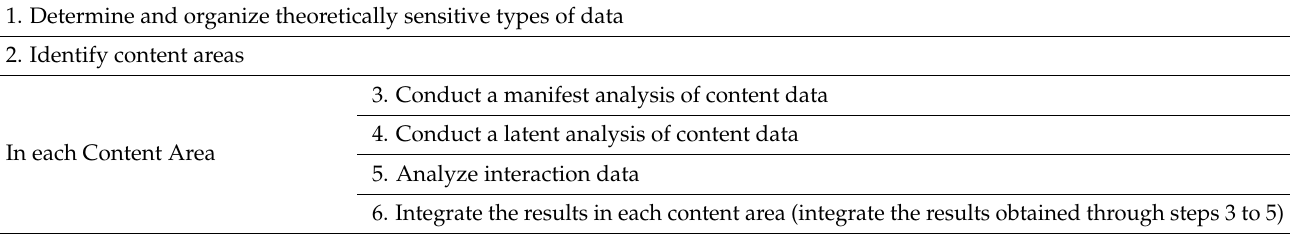
Table 3. The Steps of the Focus Group Data Analysis Framework (Nili et al. 2017, p.